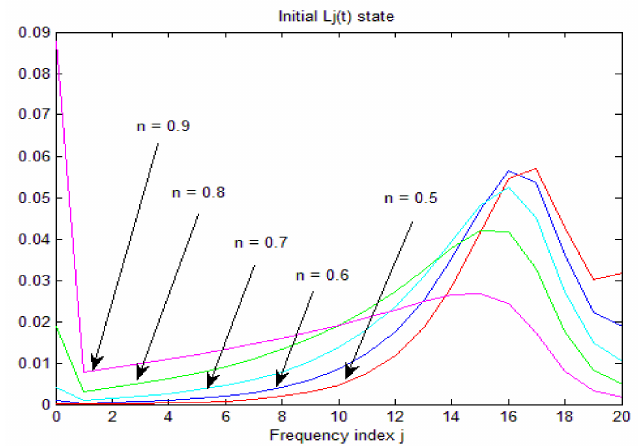
Figure 5. Distributed λ ( ω ,0 ) initial state.